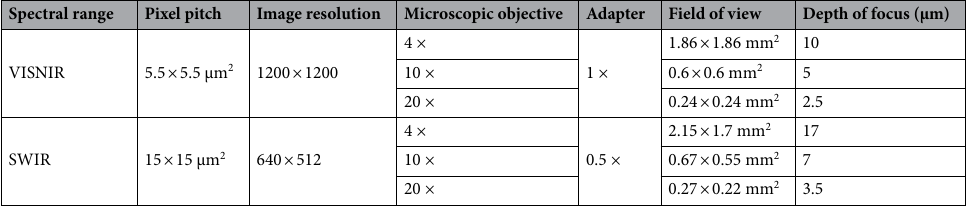
Table 1. Parameters of the experimental